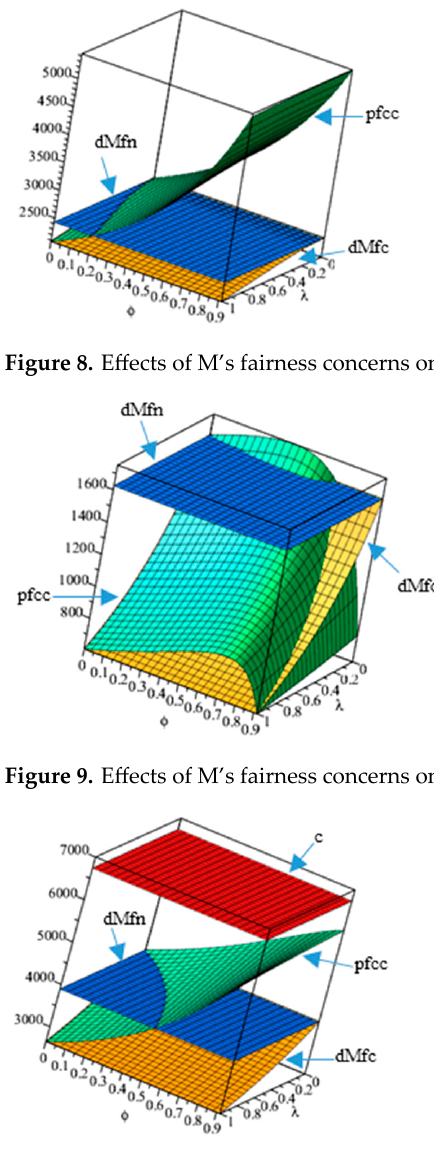
Figure 10. Effects of M’s fairness concerns on system profit.